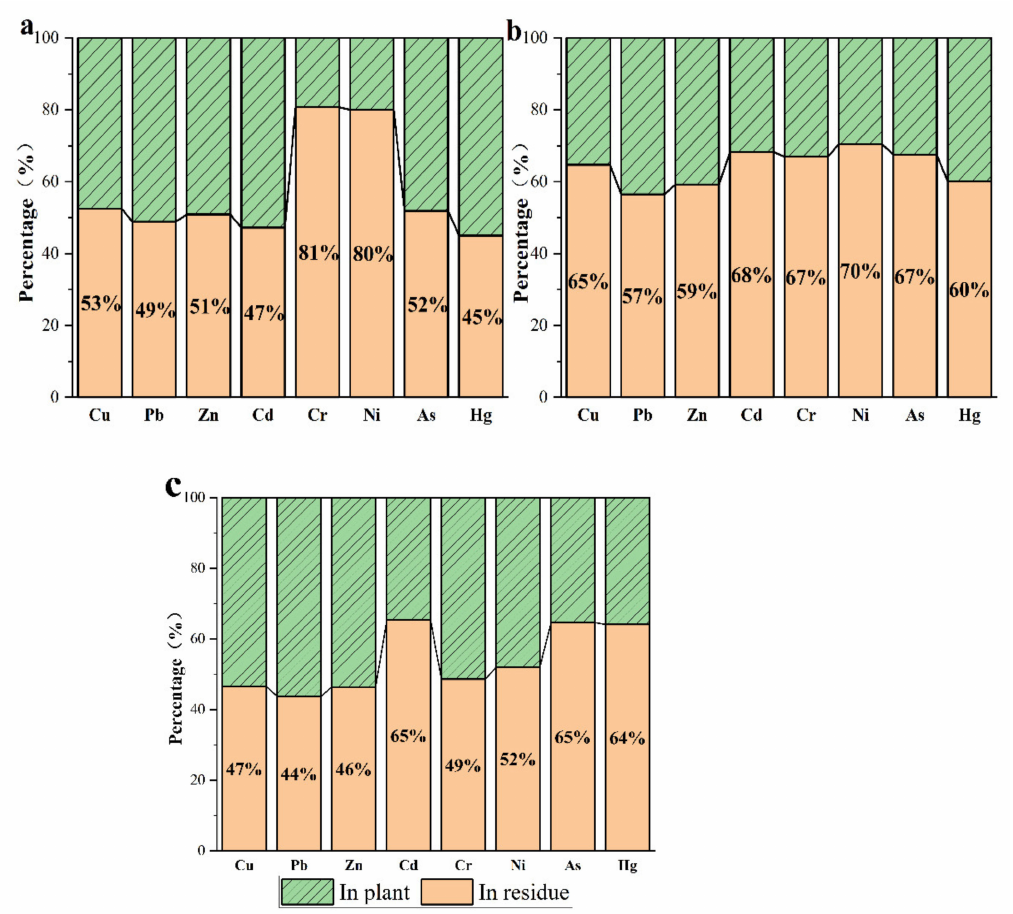
Figure 5. Proportions of heavy metals in the soil before and after planting: ( a ) high-temperature oxidation residue, ( b ) pyrolytic residue, and ( c ) thermal-washing